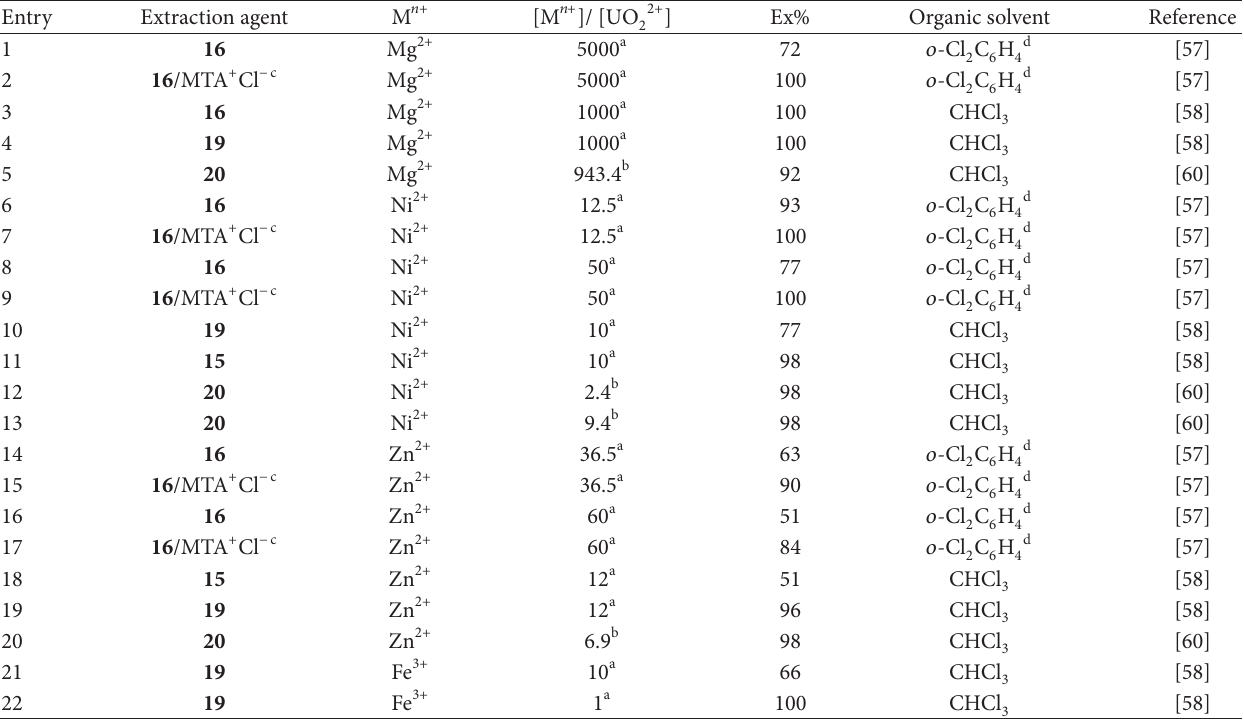
C and at pH 5.9. ∘